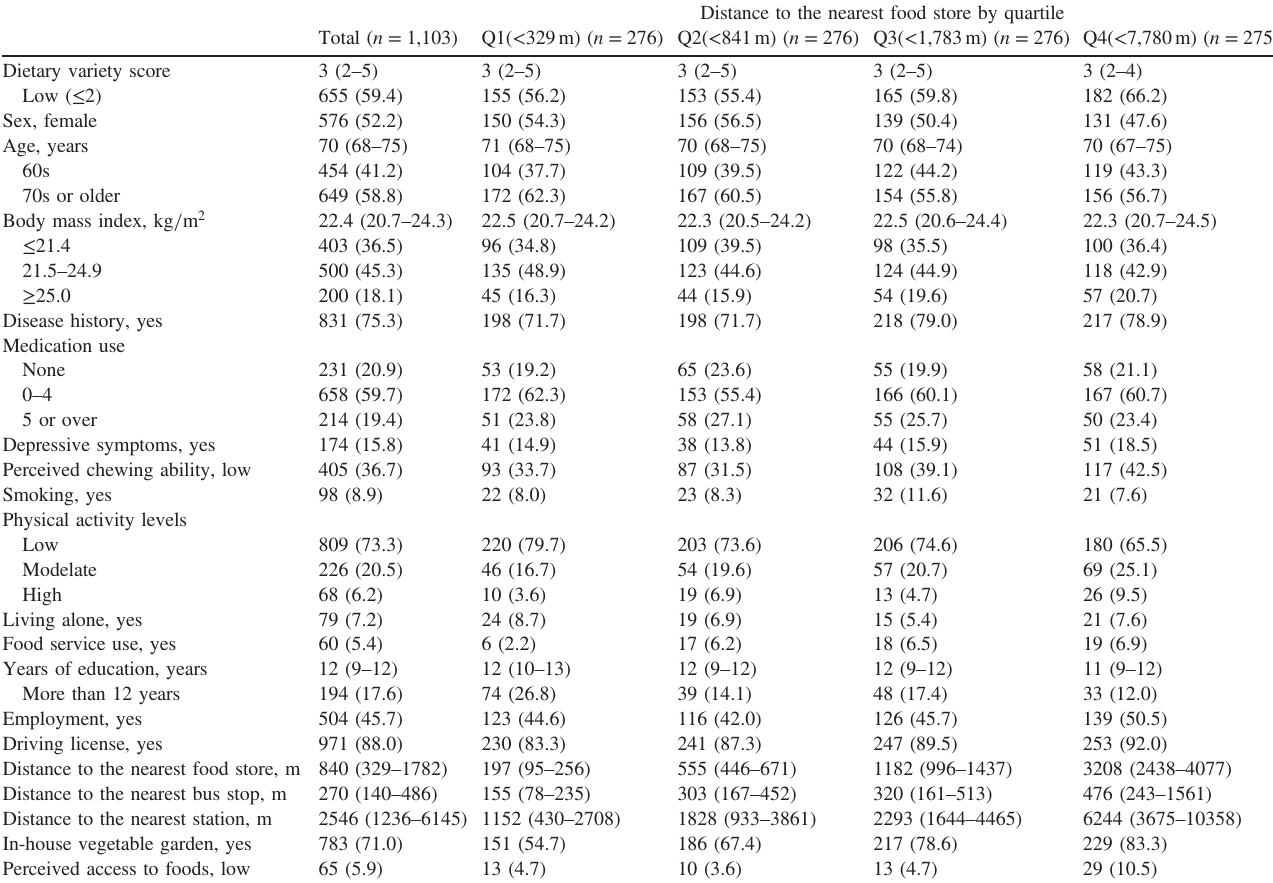
Table 1. Characteristics of participants according to distance to the nearest food store by quartiles